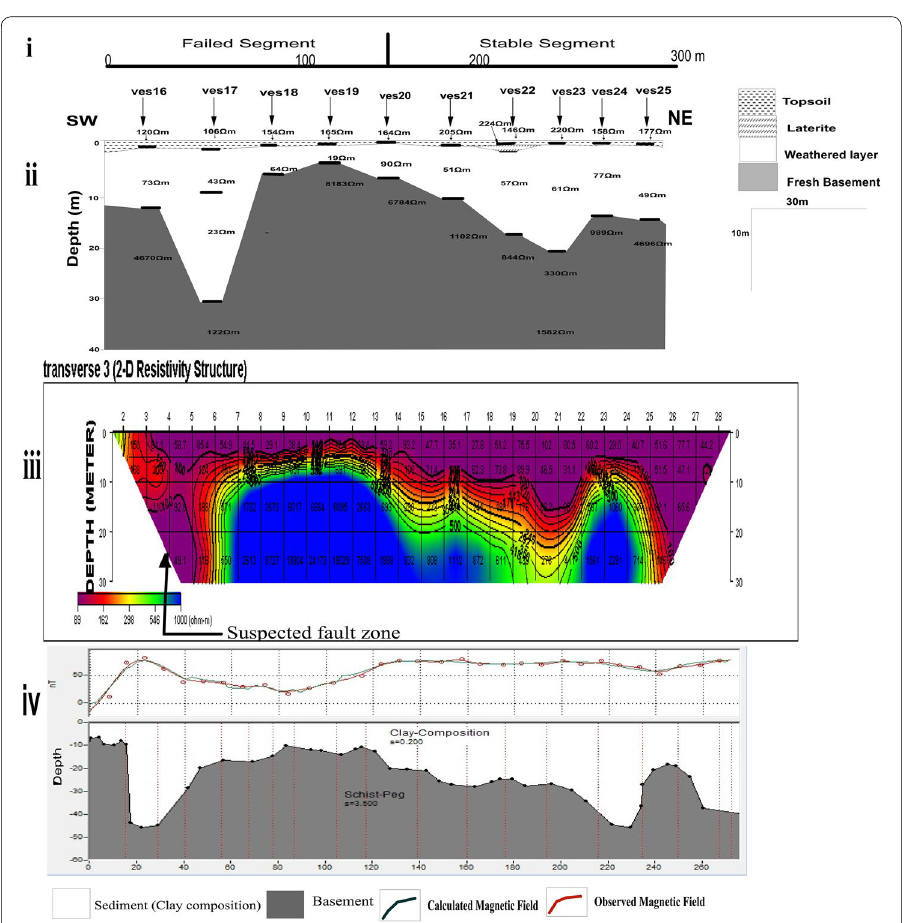
Fig. 20 Correlation of electrical resistivity and magnetic results along traverse